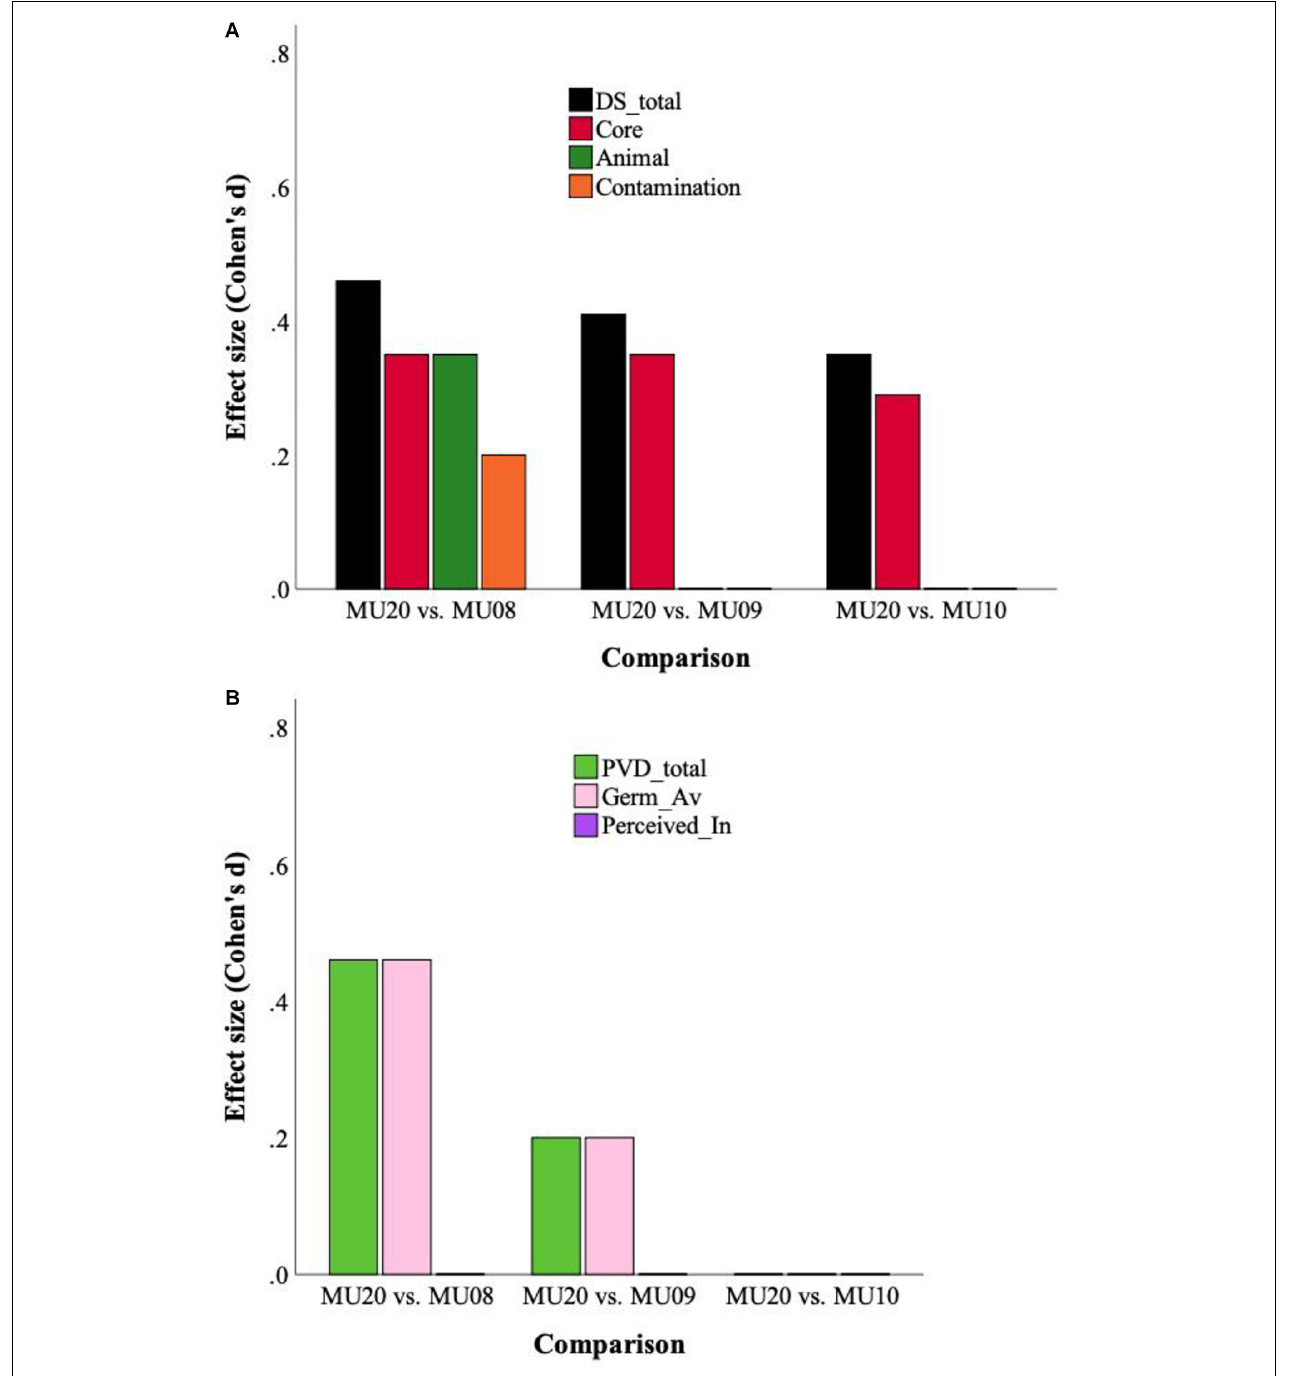
FIGURE 1 | (A) Effect sizes for Disgust Sensitivity (DS) total score and subscales, for the three raw data analyses. (B) Effect sizes for Perceived Vulnerability to Disease (PVD) and subscales (Germ aversion, Perceived infectability), for the three raw data analyses.